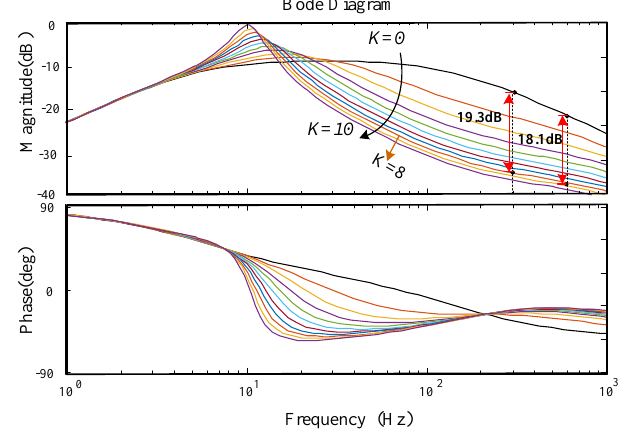
Figure 5. Bode diagrams of H pu (s) with different K .